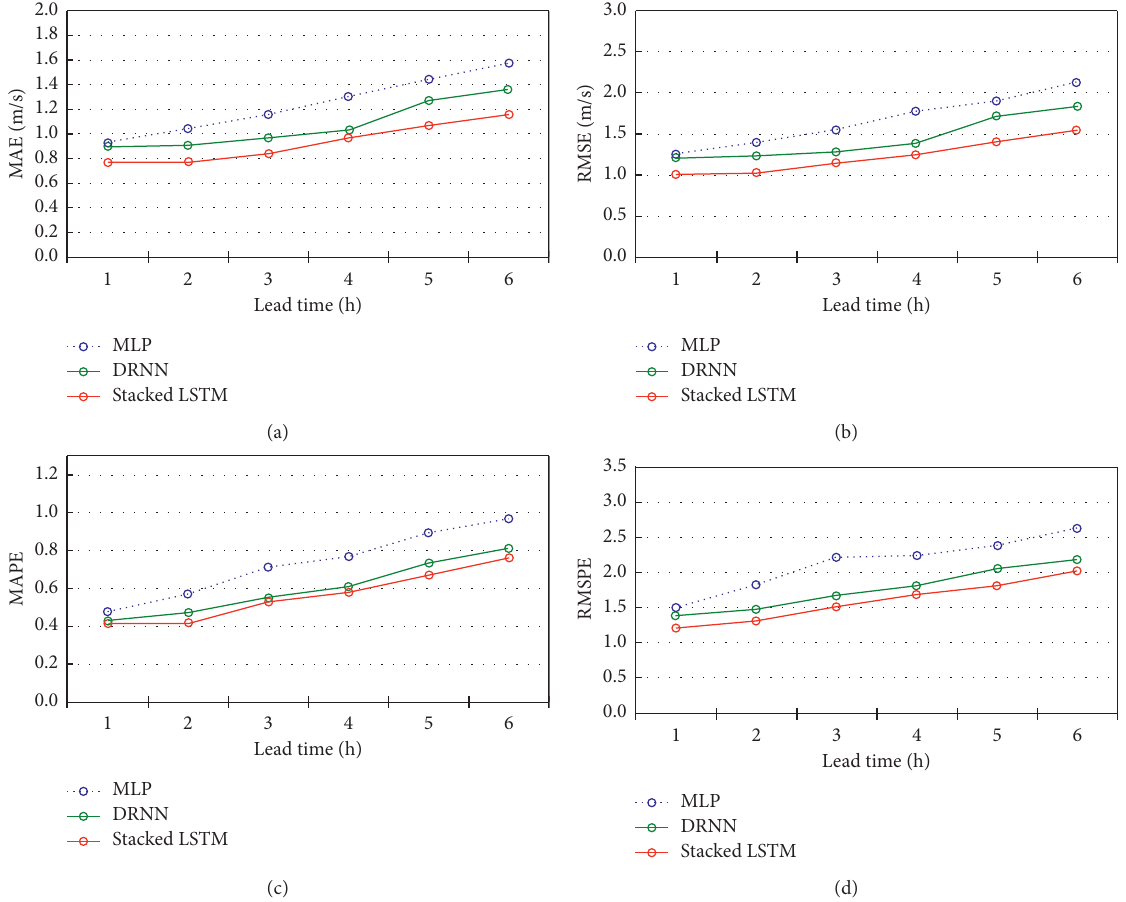
Figure 12: Performance measures at lead times from 1 to 6 h on the Taipei gauge: (a) MAE, (b) RMSE, (c) MAPE, and (d)